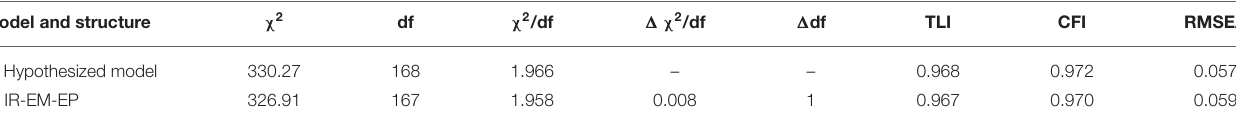
TABLE 6 | Comparison of the structural equation